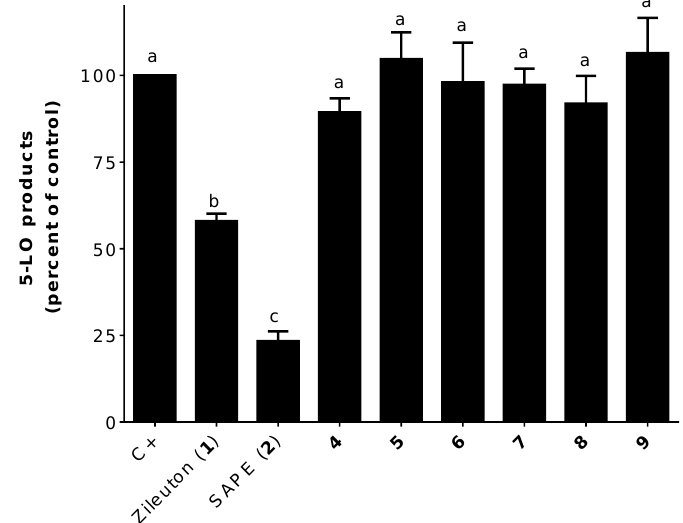
Figure 3. Inhibition of the biosynthesis of 5-lipoxygenase (5-LO) products in stimulated HEK293 cells by zileuton ( 1 ; 1 μM), SAPE ( 2 ; 1 μM), and 4–9 (1 μM). Data are expressed as means ± SEM of at least three independent experiments. Values without one common superscript (a, b, or c) are significantly different determined by one-way ANOVA with Tukey’s multiple comparison test ( p < 0.05). Analogs bearing zileuton’s ( 1 ) benzo[b]thiophene subunit combined with a phenolic acid moiety through a α , β -unsaturated ketone had interesting results as shown in Figure 4a,b. The number and position of the oxygen functions (hydroxy / methoxy groups) seem to be critical for inhibition of 5-LO product biosynthesis in stimulated HEK293 cells (Figure